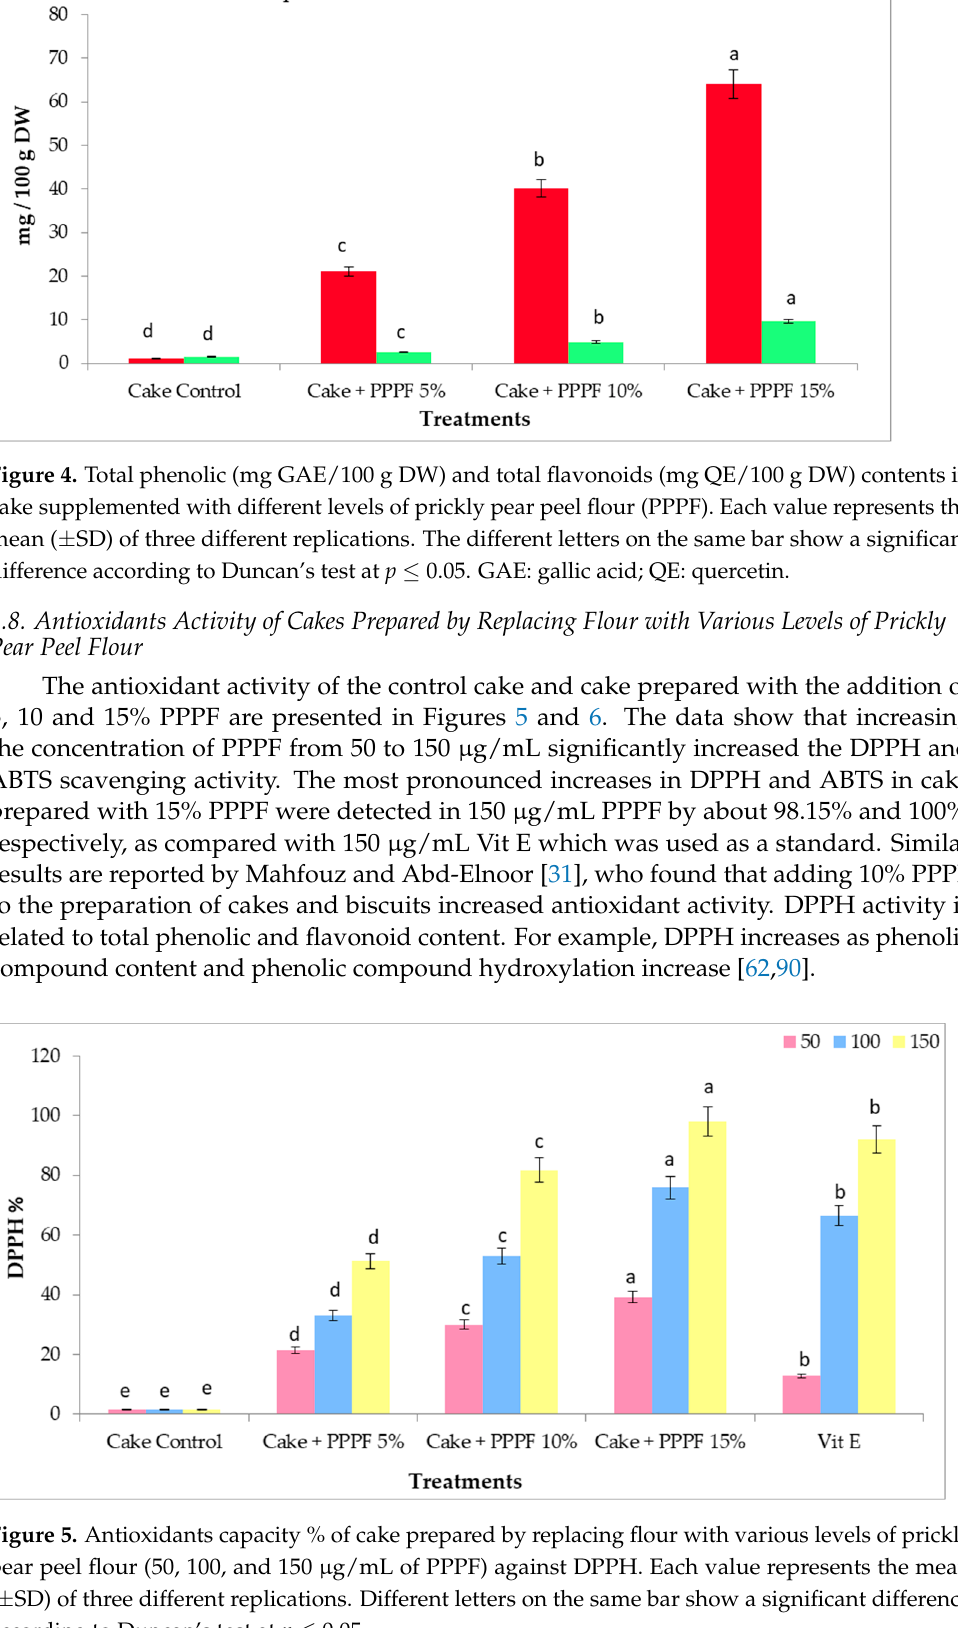
Figure 6. Antioxidants capacity % of cake treatments prepared by replacing flour with various levels of prickly pear peel flour (50, 100, and 150 µg/mL of PPPF) against ABTS. Each value repre- sents the mean (±SD) of three different replications. Different letters on the same bar show a sig- nificant difference according to Duncan’s test at p ≤ 0.05. 3.9. Minerals Content of Cakes Prepared by Replacing Flour with Different Levels of PPPF The data in Table 6 show that the mineral content of the cake prepared with the ad- dition of different levels of PPPF (5, 10, and 15%) was significantly increased as compared to the control cake. The most pronounced increases in mineral content were detected in cake prepared with 15% PPPF. These results are in line with those of Mahfouz and Abd-Elnoor [31], who found that when PPPF was added to cakes and biscuits, their mineral content increased in comparison to control samples. In addition, cations like magnesium and calcium improve the mechanical characteristics of gluten for interactions with amino acid side groups [91].